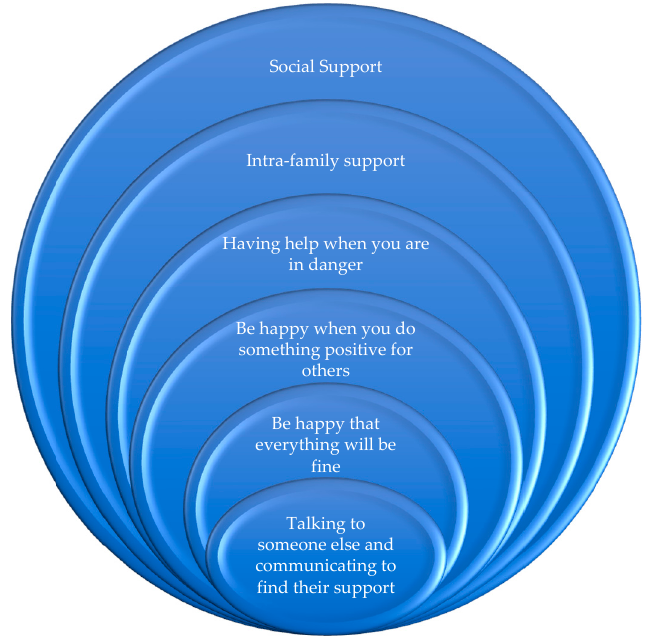
Figure 2. Sources of resilience. Source: Own elaboration from Grotberg [37], Walsh [38], and Adger [39].